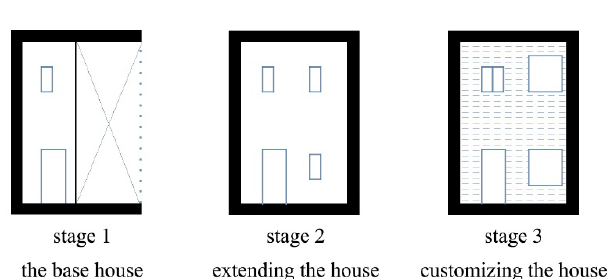
Figure 1. Three phases of incremental